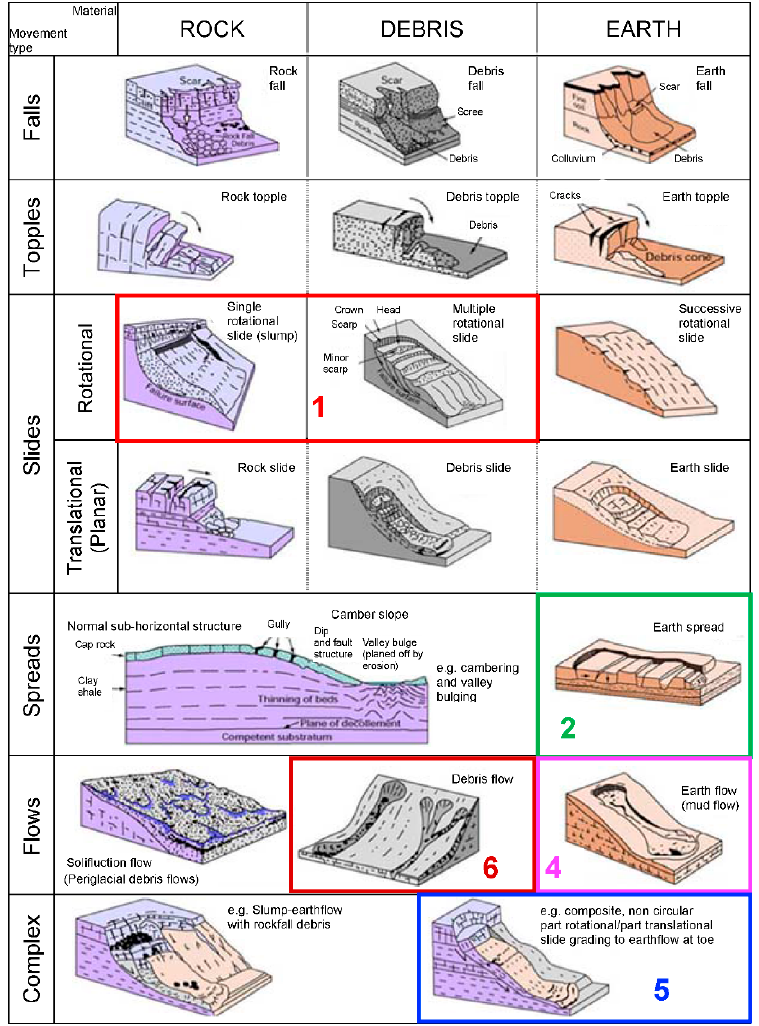
// www.bgs.ac.uk-British Geological